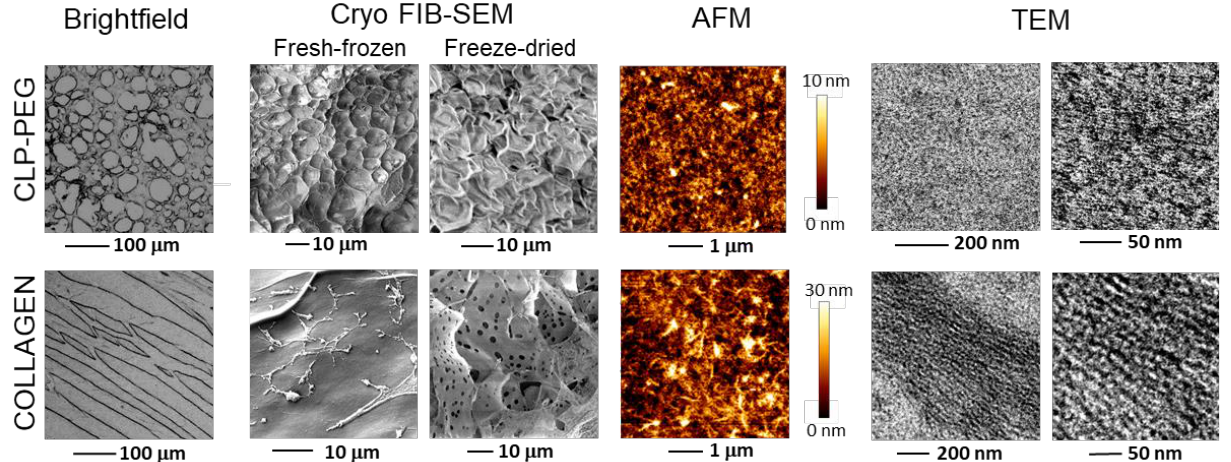
Figure 2. Micro- and nanoscale imaging of the CLP-PEG and collagen hydrogel structure by electron (SEM, TEM) and atomic force microscopy (AFM) (SEM, TEM) and atomic force microscopy (AFM) techniques.